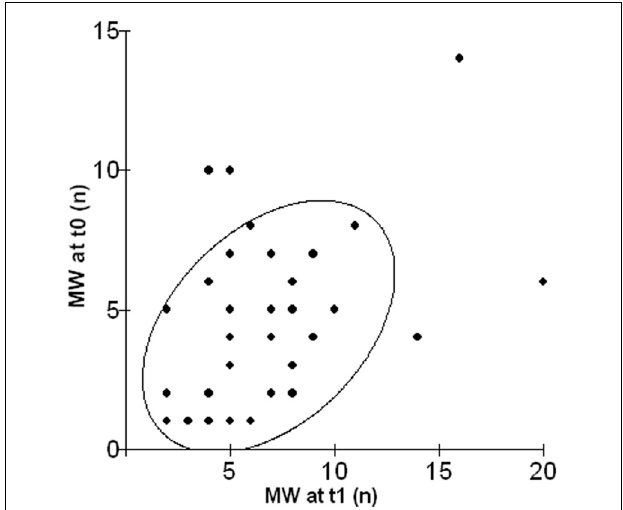
FIGURE 1 | Scatterplot illustrating the relationship between the number of episodes of MW in the lab (MW at t0) and in daily life after 1 year (MW at t1).